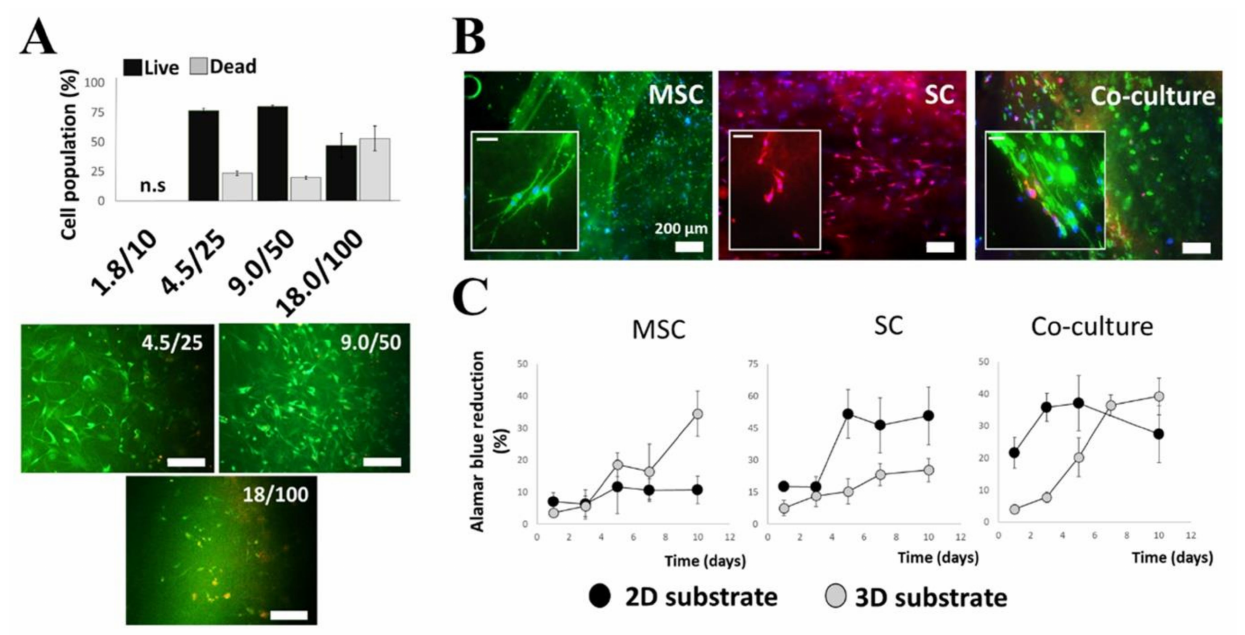
Figure 1. ( A ) Cell viability: Schwann cells (SCs) and MSCs were co-cultured (1:1) in fibrin hydrogels using various fibrinogen/thrombin ratios to alter resultant gel stiffness. The softest hydrogel is 1.8/10 and the stiffest is 18/100. Viable populations were best for cells within 4.5/25 and 9.0/50. ( B ) Immunofluorescence staining of SCs, MSCs, and co-cultured cells within 9.0/50 fibrin (3D) substrates to ascertain cell morphology. SCs were stained for S100 (red), MSCs for CD90 (green), and cell nuclei with DAPI (blue). ( C ) AlamarBlue reduction profiles to ascertain comparative cell survival and proliferation using 2D and 3D substrates. Error bars are standard deviations from the mean; n = 6; scale bars are 100 µ m except where stated otherwise and are 50 µ m for image inserts in ( B